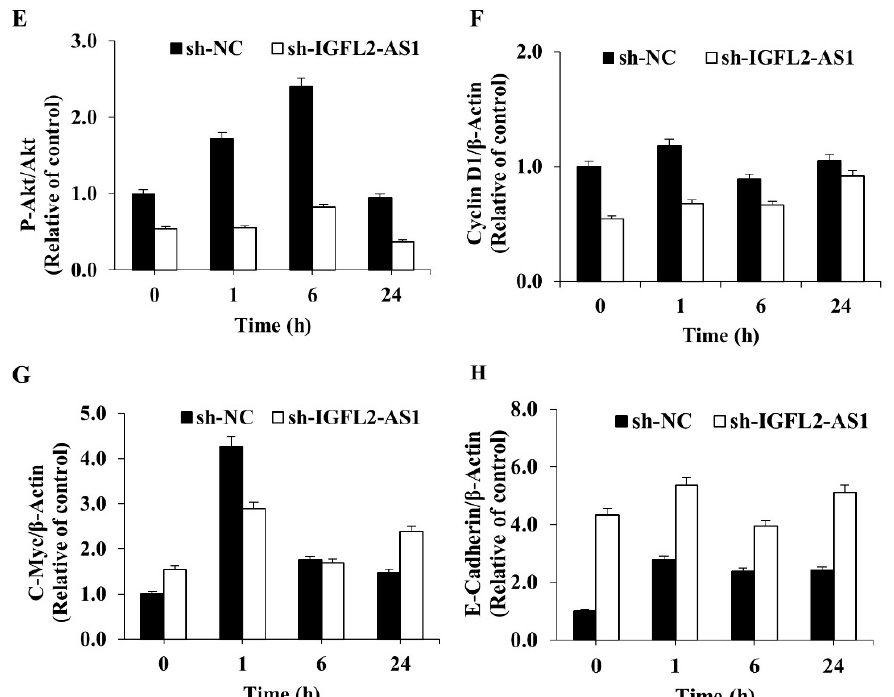
Figure 4. AKT pathway signaling is suppressed by sh-IGFL2-AS1. ( A ) Schematic depicting the IGFL2-AS1 pathway. ( B ) Relative transcription of ARPP19, measured using qRT PCR. The graph depicts the levels of ARPP19 in the indicated cell lines. Data are normalized to those of the sh-NC- HT29 cell line; error bars indicate SDs. *** p < 0.001. ( C ) Protein expression of ARPP19, measured by western blotting. The expression of β -actin was used as a loading control. ( D ) Western blot analyses of various proteins downstream of AKT. Cells incubated as indicated after irradiation (3 Gy) were lysed and analyzed by western blotting; β -actin was used as a loading control. ( E – H ) Densitometric measurements of protein expressions, corresponding to ( D ). The results are presented as the ratio of phosphor-AKT/AKT ( E ), cyclin D1/ β -actin ( F ), c-Myc/ β -actin ( G ), and E-cadherin/ β -actin ( H